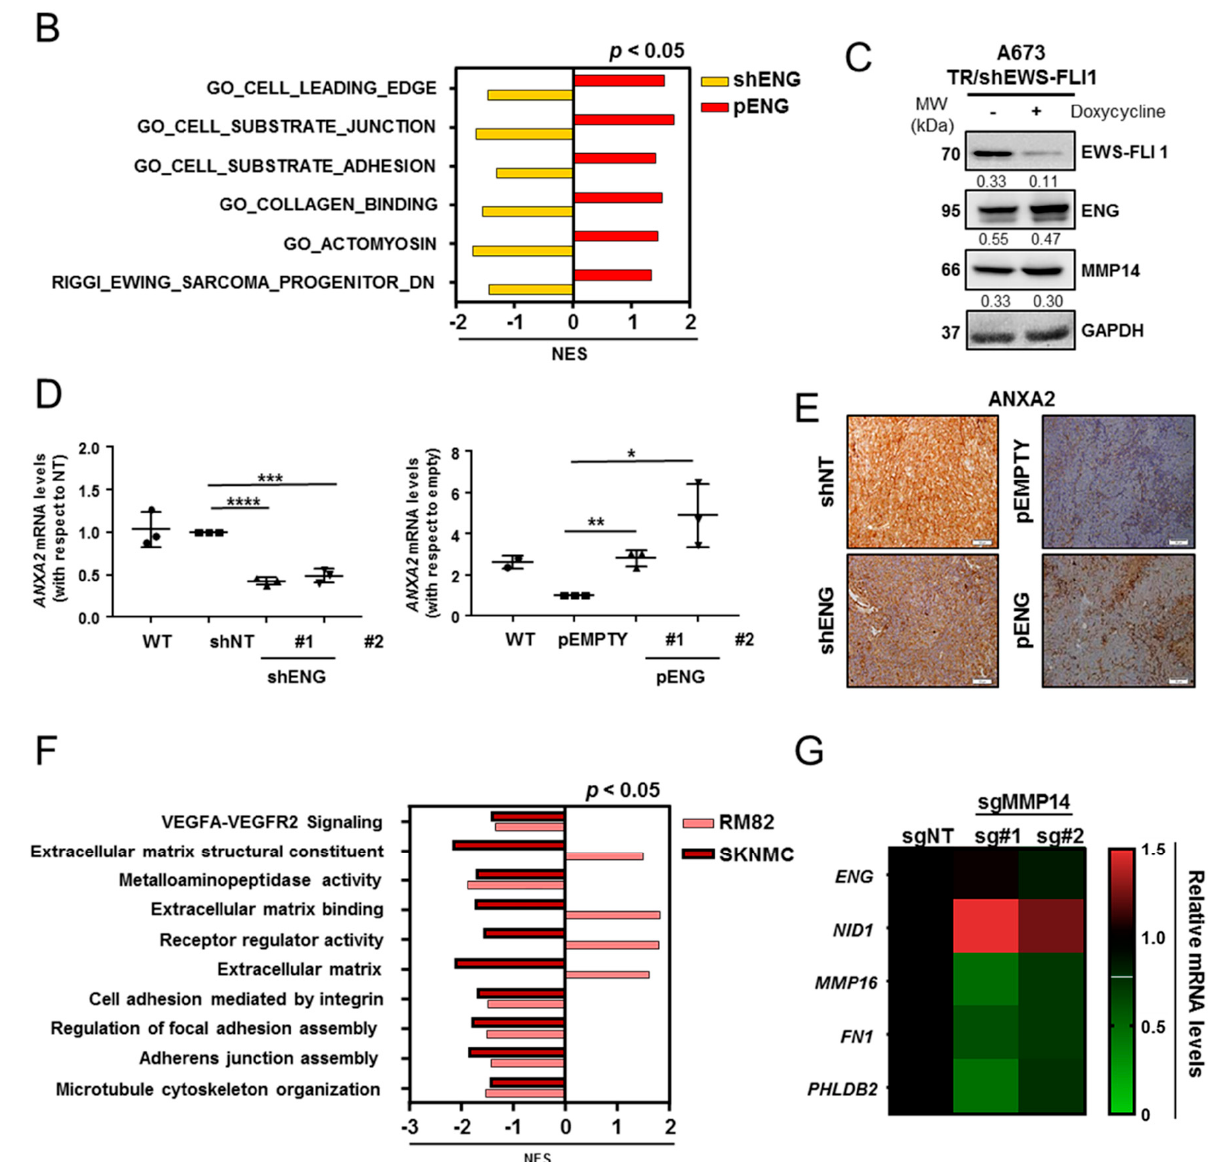
Figure 3. ENG and MMP14 regulate transcriptional pathways related to cell migration and cell– substrate adhesion in ES cells. ( A ) Joint transcriptomic analysis of the shENG models from RM82 and SK-N-MC revealed common downregulated GO terms related to cell–substrate adhesion and ECM organization. ( B ) Joint transcriptomic analysis of RM82-ENG-downregulated model and TC71-ENG- upregulated model showed significantly inverse gene signatures regarding cell–substrate junction and adhesion and ECM organization. ( C ) Expression of ENG and MMP14 was not dependent on EWS- FLI1 expression, as detected by WB analysis. ( D ) qRT-PCR validation of ANXA2 dysregulation on the RM82 shENG model (#1 and #2 clones) versus the shNT control and on the TC71 pENG model (#1 and #2 clones) versus the pEMPTY control. ( E ) The downregulated and overexpressed levels of ANXA2 were validated in vivo in the shENG and pENG models, respectively. ( F ) Common gene categories were observed when transcriptomic data from RM82 sgMMP14 and SK-N-MC sgMMP14 were evaluated by GSEA. The most significant common pathways included ECM structural constituent, metalloaminopeptidase activity, and ECM binding. ( G ) qRT-PCR validation of the transcriptomic analysis of RM82 sgMMP14 confirmed the gene deregulation of the sgMMP14 model. FN1 and PHLDB2 were significantly downregulated in both RM82 shMM14 clones. Statistical significance was evaluated by paired two-tailed Student’s t -test in ( D ) (ns, non-significant; * p < 0.05; ** p < 0.01; *** p < 0.001; and **** p < 0.0001). NES, Normalized Enrichment